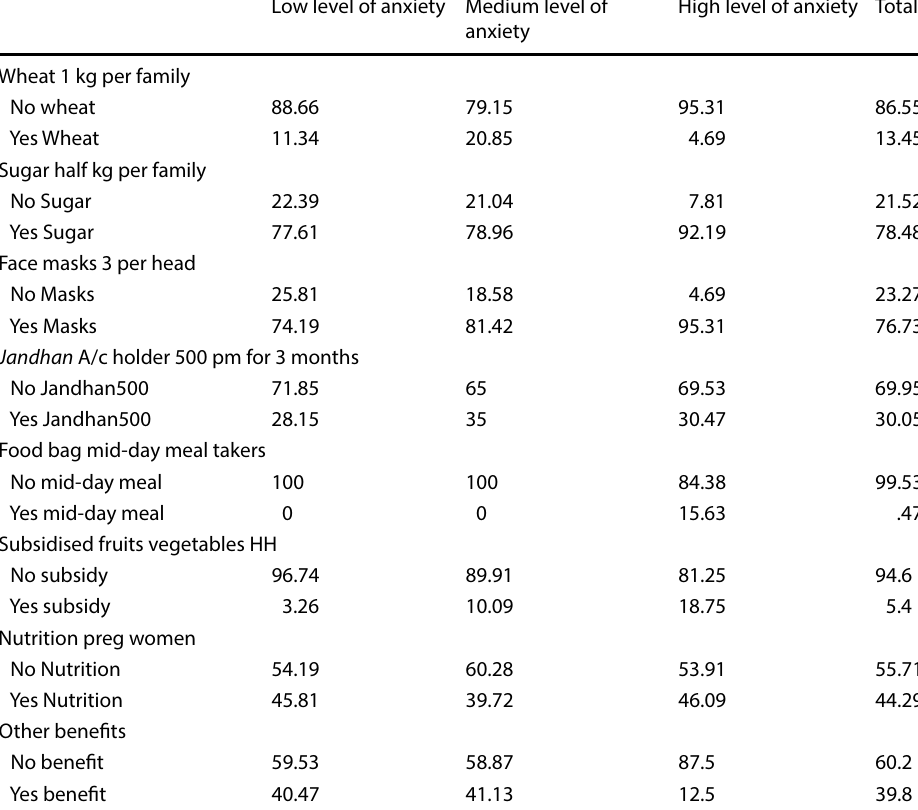
Discover Mental Health Table 3 Policies measures to ameliorate conditions of